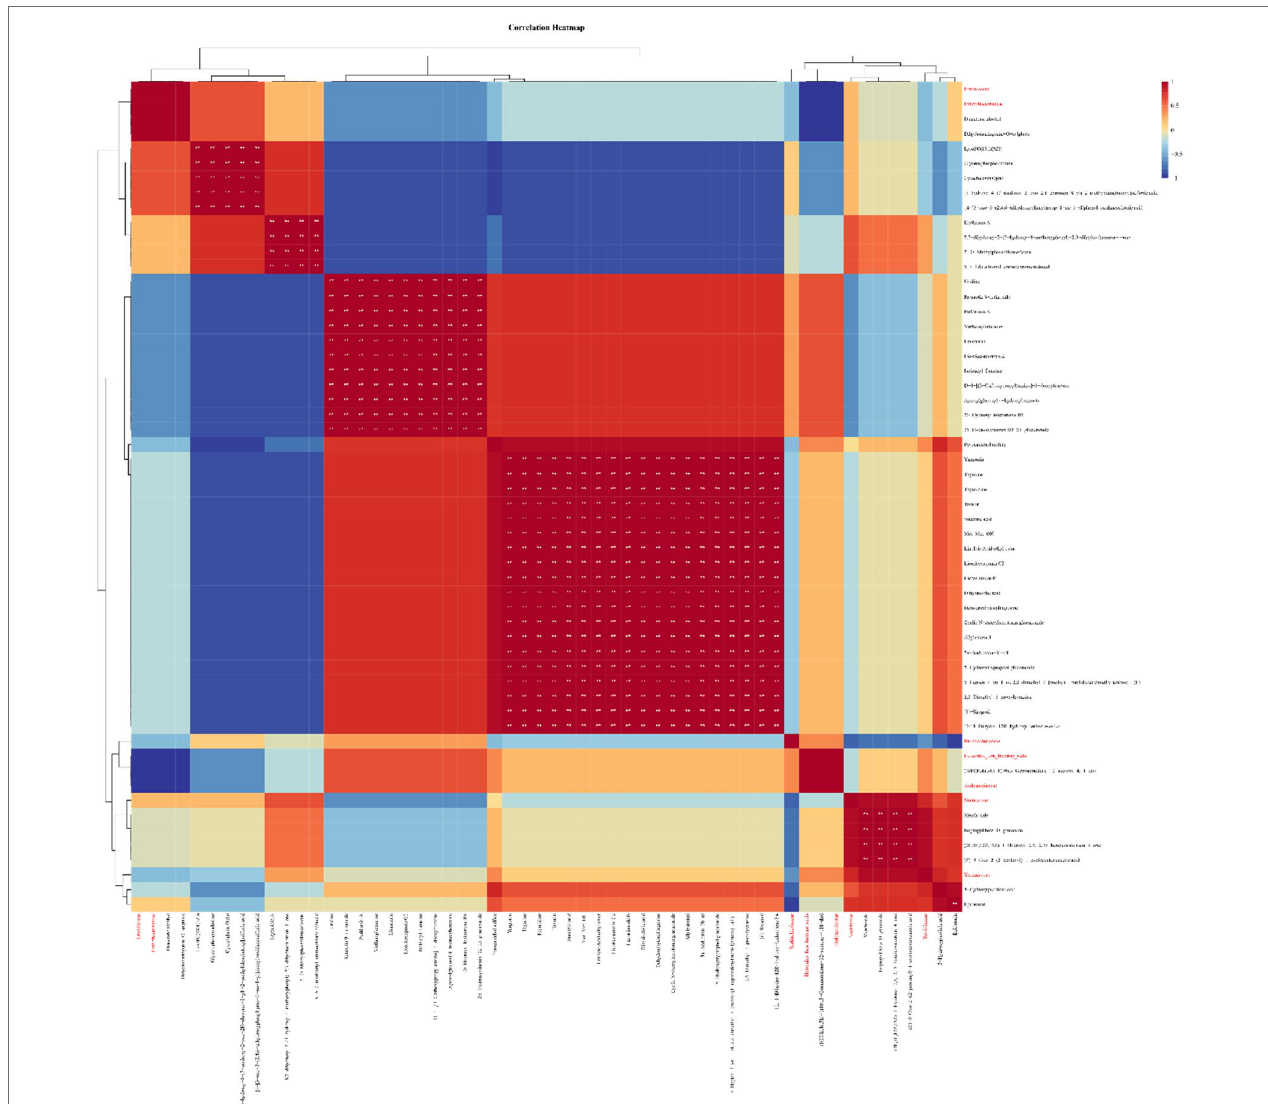
FIGURE 5 | The correlation between the main metabolites and the main endophytic microorganisms of licorice (red font is the family of the microorganism, black font is the identified metabolite, the red square indicates positive correlation, and the blue square indicates negative correlation, ** is p <